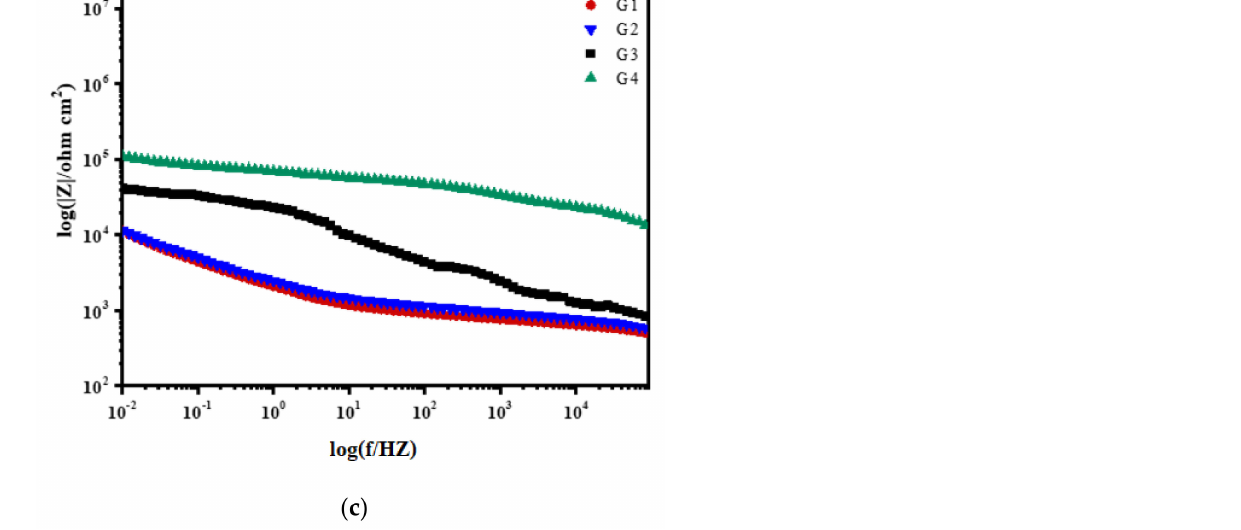
Figure 11. Each coating’s Bode pattern for immersion for 60 days: ( a ) 20% Seawater; ( b ) 40% Seawater; ( c ) 60%